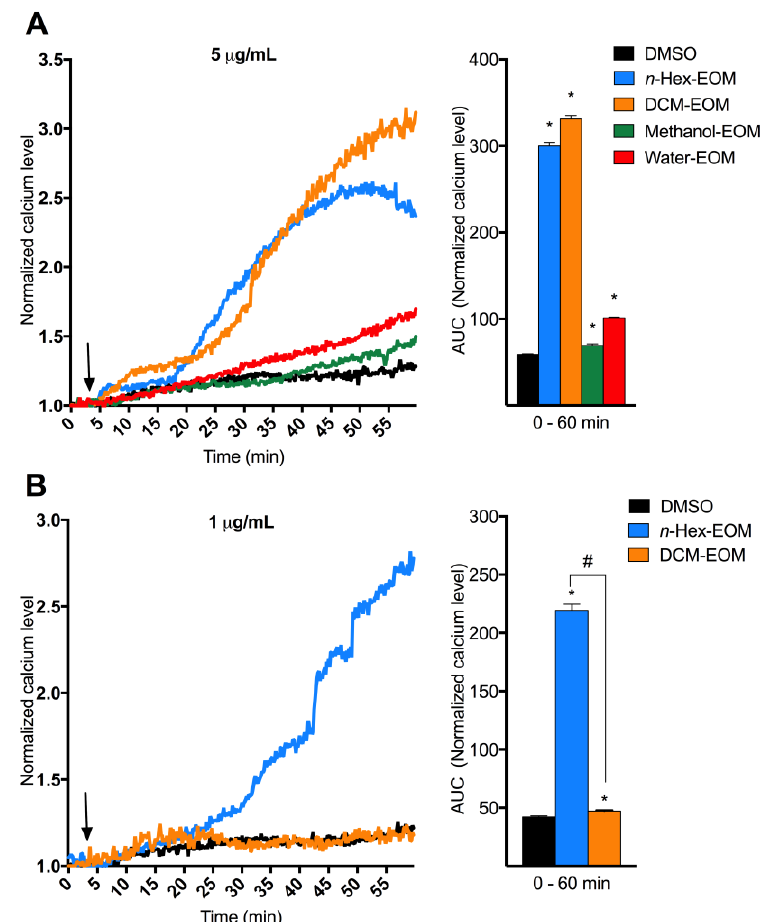
Figure 2. Effects of DEP-EOM on [Ca 2+ ] i in human microvascular endothelial cells (HMEC-1). ( A ) Three min after measurements were started (arrow), the cells were exposed to one of the four DEP-EOM ( n -Hex-, DCM-, Methanol or Water-EOM) at concentrations corresponding to 5 µ g/mL of the original DEPs or vehicle control (DMSO); ( B ) To evaluate effects at low concentrations, three min after measurements were started (arrow), cells were exposed to n -Hex- and DCM-EOM at concentrations corresponding to 1 µ g/mL of the original DEPs or vehicle control (DMSO). [Ca 2+ ] i levels measured by normalized ratio of the Fura2-AM probe during exposure is presented as a graph and the area under the curve (AUC) from 1.0 at the Y -axis and 0–60 min, as mean and mean ± SEM ( n = 3), respectively. * Significantly different from DMSO ( p < 0.05). # Significantly different from DCM-EOM ( p < 0.05).